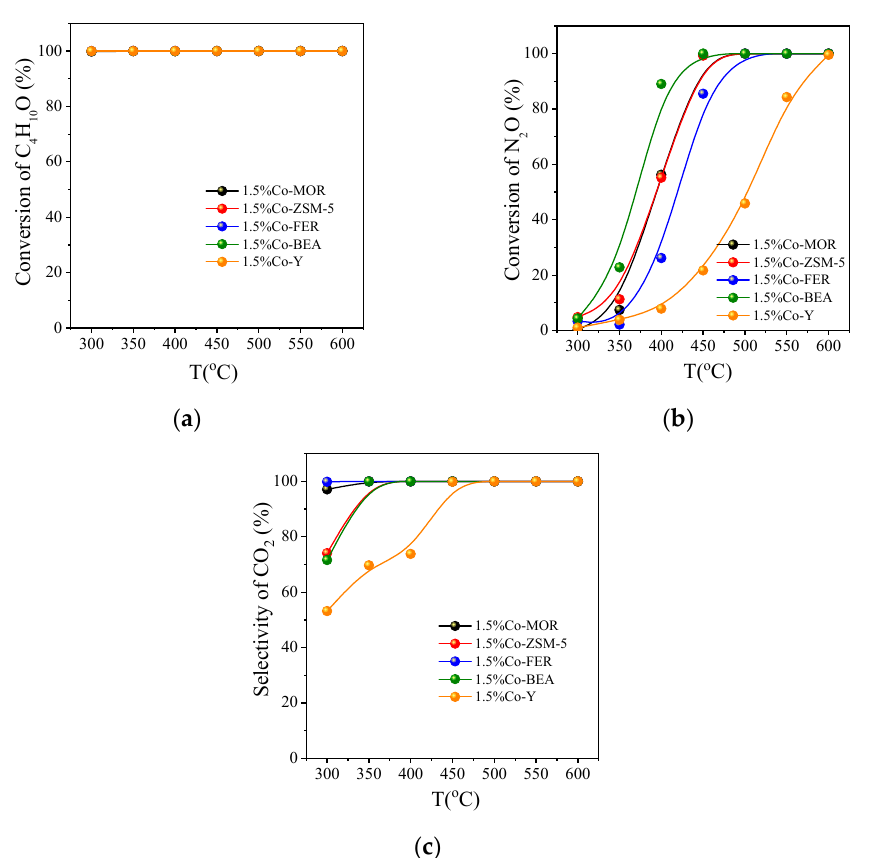
Figure 7. Catalytic oxidation of tert-butanol on molecular sieves loaded with 1.5% Co: ( a ) the conversion of C 4 H 10 O; ( b ) the conversion of N 2 O; ( c ) the selectivity of CO 2 ; reaction conditions: GHSV = 8000 h − 1 , C 4 H 10 O:N 2 O:O 2 :He = 0.2:7:5:87.8.